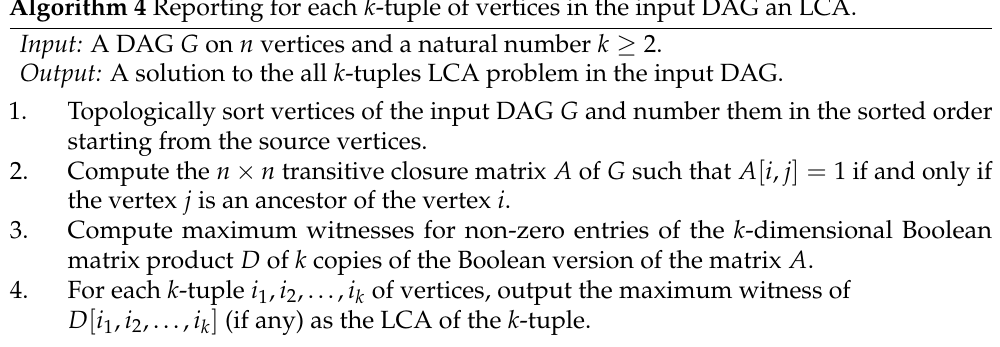
Algorithm 4 Reporting for each k -tuple of vertices in the input DAG an LCA.